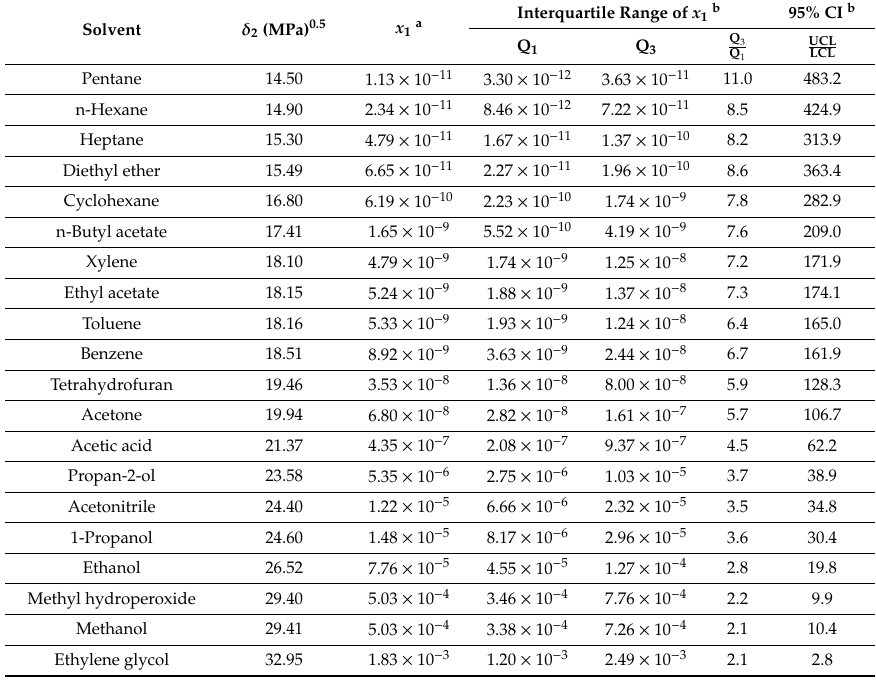
Table 4. Calculated mole fraction solubility x 1 of l -ascorbic acid at 25 ◦ C for various solvent solubility parameters δ 2